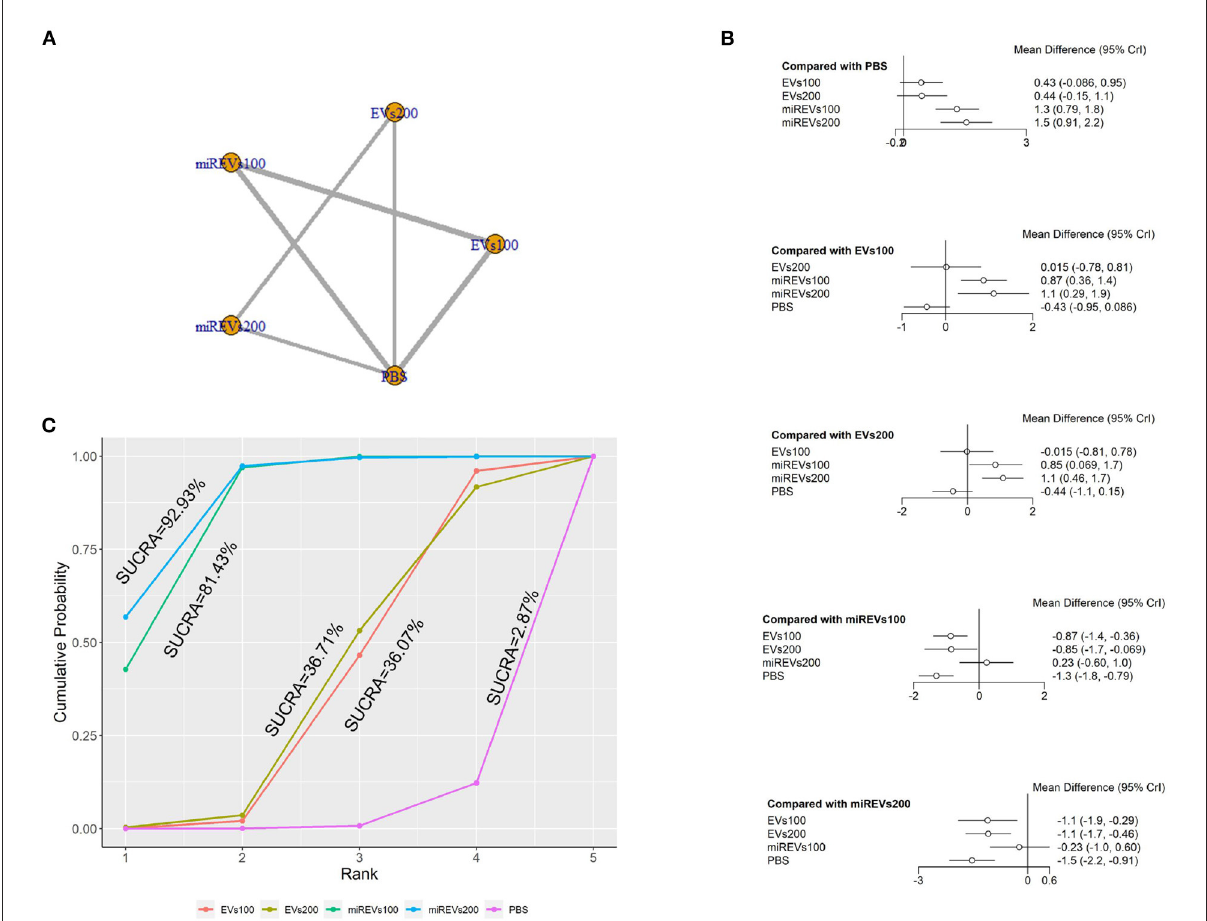
FIGURE4 The network meta-analysis of BBB scores at different dosages at 3 days after administration. (A) Network plot; (B) Forest plot; (C) SUCRA plot. EVs100, EVs at 100 µ g dosages; EVs200, EVs at 200 µ g dosages; miREVs100, miRNAs-loaded EVs at 100 µ g dosages; miREVs200, miRNAs-loaded EVs at 200 µ g